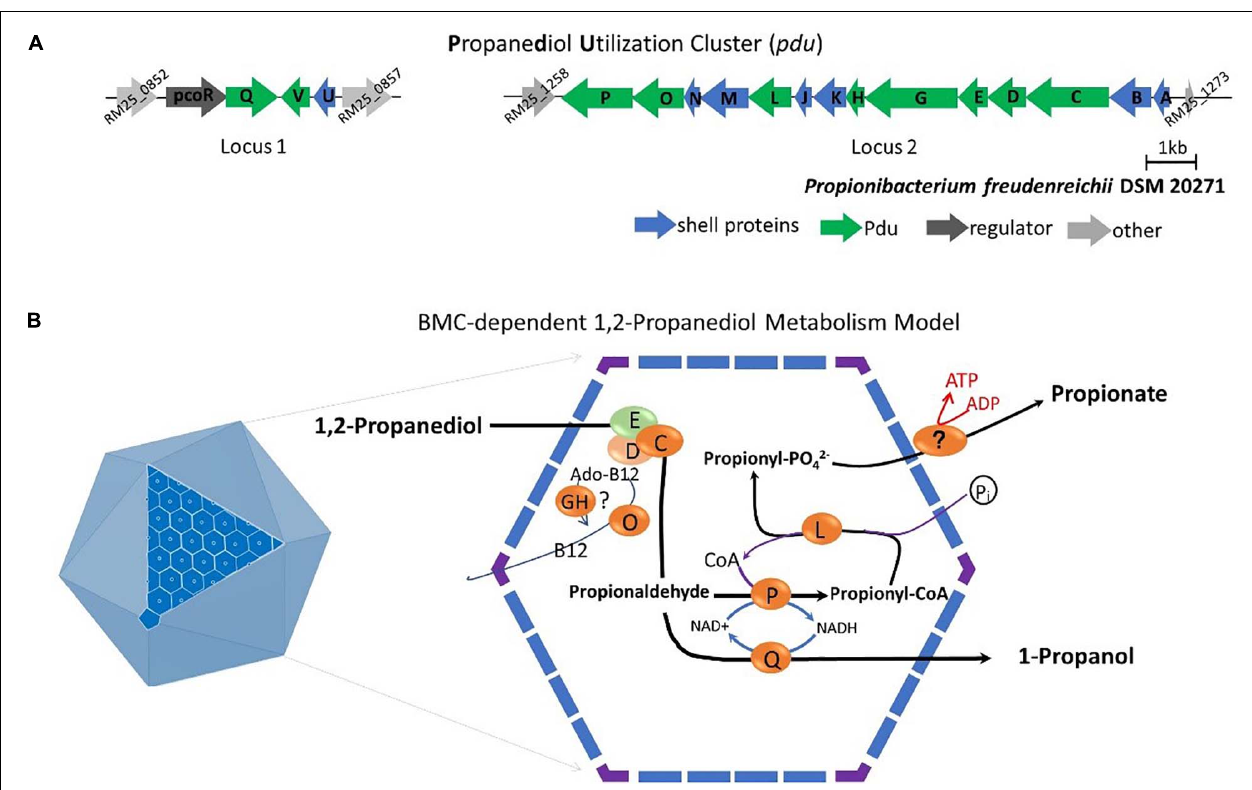
FIGURE 5 | (A) Analysis of the pdu gene cluster (Details in Supplementary File 1 ). Characters in orange represent Pdu enzymes, in blue represent BMC shell proteins, in dark represent regulator and in gray represent unannotated proteins with gene ID. (B) Model of BMC-dependent 1,2-propanediol metabolism. In the left, the icosahedral diagram represent BMC with one surface showing the assembly of shell proteins. In the right, the metabolic pathway of 1,2-propanediol metabolism. PduCDE,